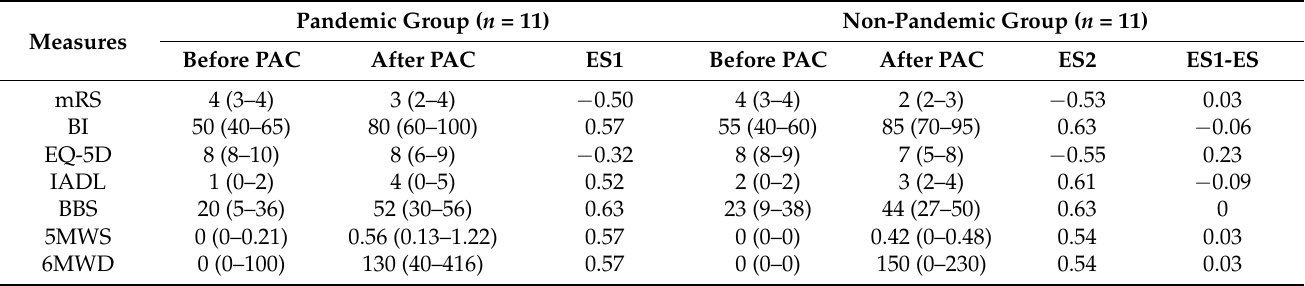
Table 3. Differences in effect size (ES) in each functional status measure before and after the PAC program: comparison between different